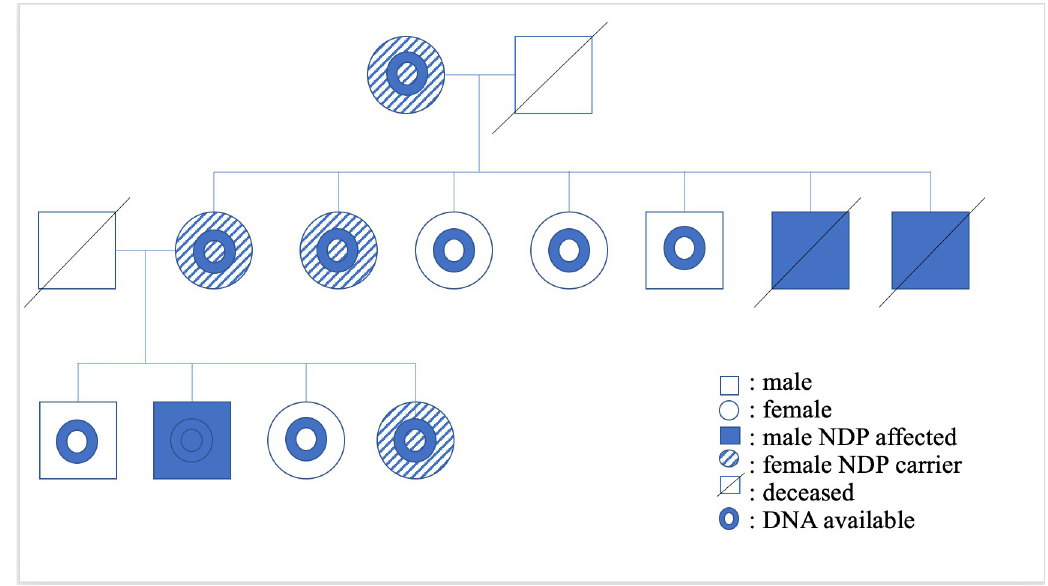
Fig 1. Pedigree of RD affected and related ECS. RD-affected and obligate carriers (sires and dams of the RD-affected ECS), and the dog(s) from which DNA was available are indicated in the legend. Segregation is consistent with an X-linked autosomal recessive mode of